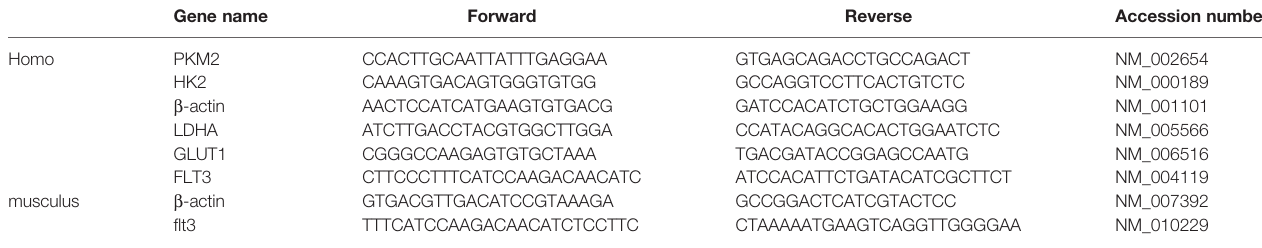
TABLE 1 | Speci fi c primer sequences used in this paper (5 ′ -3 ′